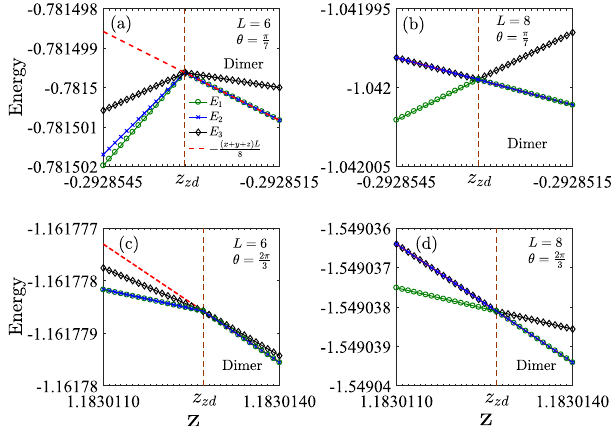
Figure 3. Energy spectra of the lowest three levels for small lattice sites with PBC based on exact diagonalization method. ( a , b ) show the exact dimer phase boundary ( z ex π 6 and L 8 . ( c , d ) show the exact dimer phase boundary ( z ex θ 7 with L = = = 2 π 6 and L 8 . In the exact dimer phase, the GS energy of the two-fold degenerate states is given θ 3 with L = = = by Eq. (15) (red dashed